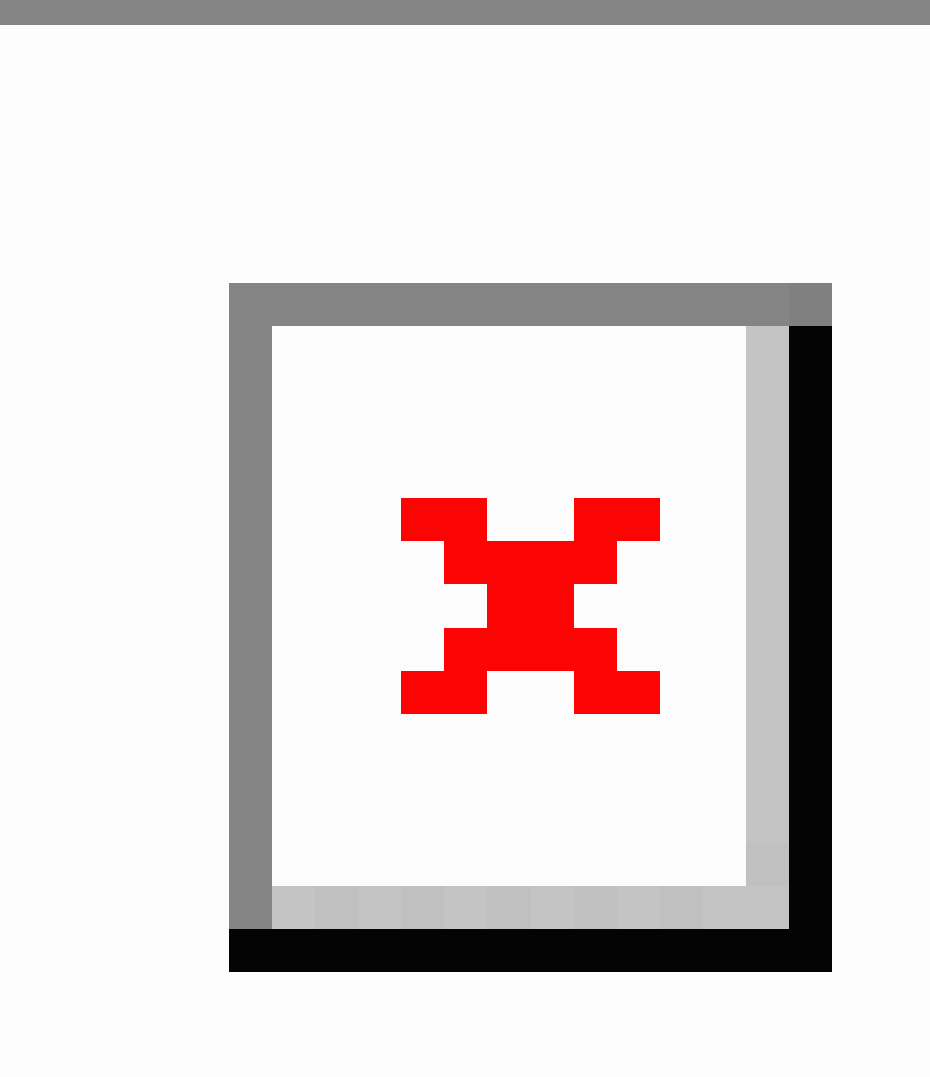
were women (76.27%, 1234/1618; 95% CI 74.2-78.3) than